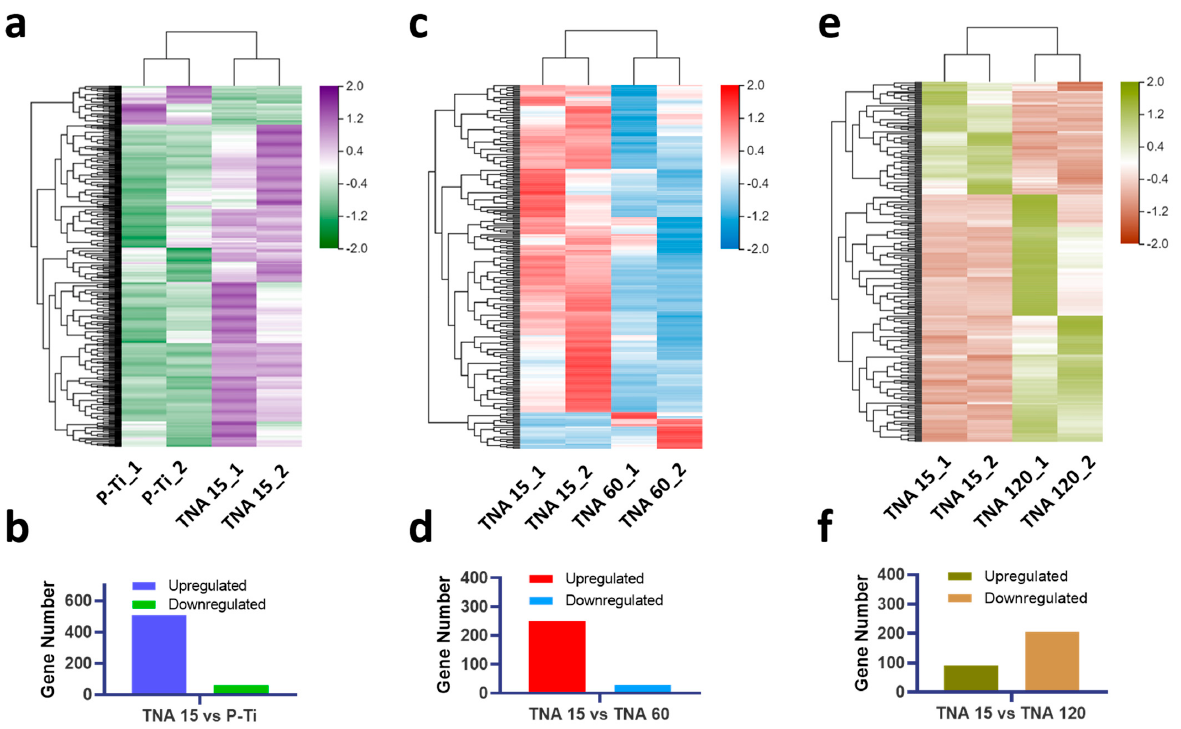
Figure 4. Visualization of different LncRNA expression profiles with heatmap. ( a ) P-Ti vs. TNA 15. ( b ) TNA 60 vs. TNA 15. ( c ) TNA 120 vs. TNA 15. Quantitative results of the LncRNA expression profiles. ( d ) P-Ti vs. TNA 15. ( e ) TNA 60 vs. TNA 15. ( f ) TNA 120 vs. TNA